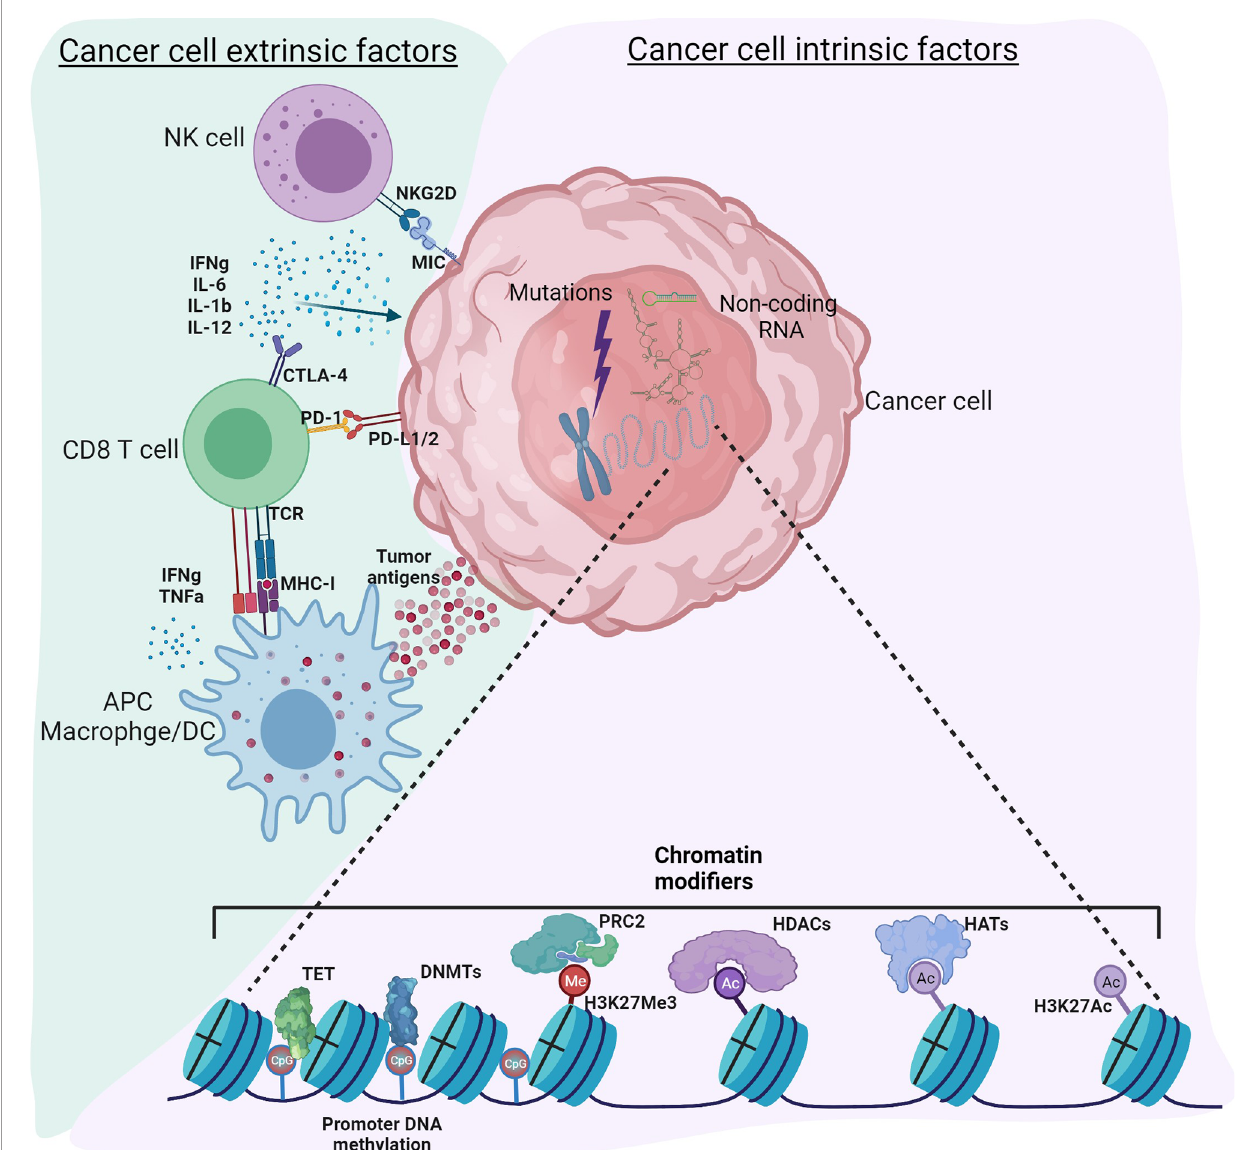
FIGURE 1 | Tumor intrinsic and extrinsic factors regulating immune responses in the tumor microenvironment. Cancer cell intrinsic factors such as genomic mutations, chromatin modi fi ers and non-coding RNA regulate tumor initiation, propagation as well as immunogenicity. Epigenetic modi fi cations such as DNA methylation, histone acetylation and methylation regulate gene expression. Non-coding RNA including long non-coding RNA, microRNA, circular non-coding RNA regulate gene transcription as well as mRNA stability. Other mechanisms intrinsic to cancer cells include expression of immunosuppressive cytokines to facilitate escape from anti-tumor immunity, expression of immunosuppressive molecules such as PD-L1 and PD-L2, suppression of antigen processing and presentation machinery and tumor associated antigens. Cancer cell extrinsic factors include tumor in fi ltrated immune cells, fi broblasts, stromal cells and endothelial cells. Extrinsic factors also include secretory factors such as cytokines, chemokines, metabolites, growth factors and immune checkpoint molecules. Tumor associated antigens presented by antigen presenting cells such as macrophages, dendritic cells activate CD8 T-cells for effective anti-tumor immunity. However, immune checkpoint molecules expressed by cancer cells regulate the in fl ammatory status of the tumor tamping down the in fl ammation. Use of epigenetic modi fi ers such as DNMT inhibitors, HDAC inhibitors, BET inhibitors etc. can alter these reversible modi fi cations to enhance anti-tumor immunity. Figure created with